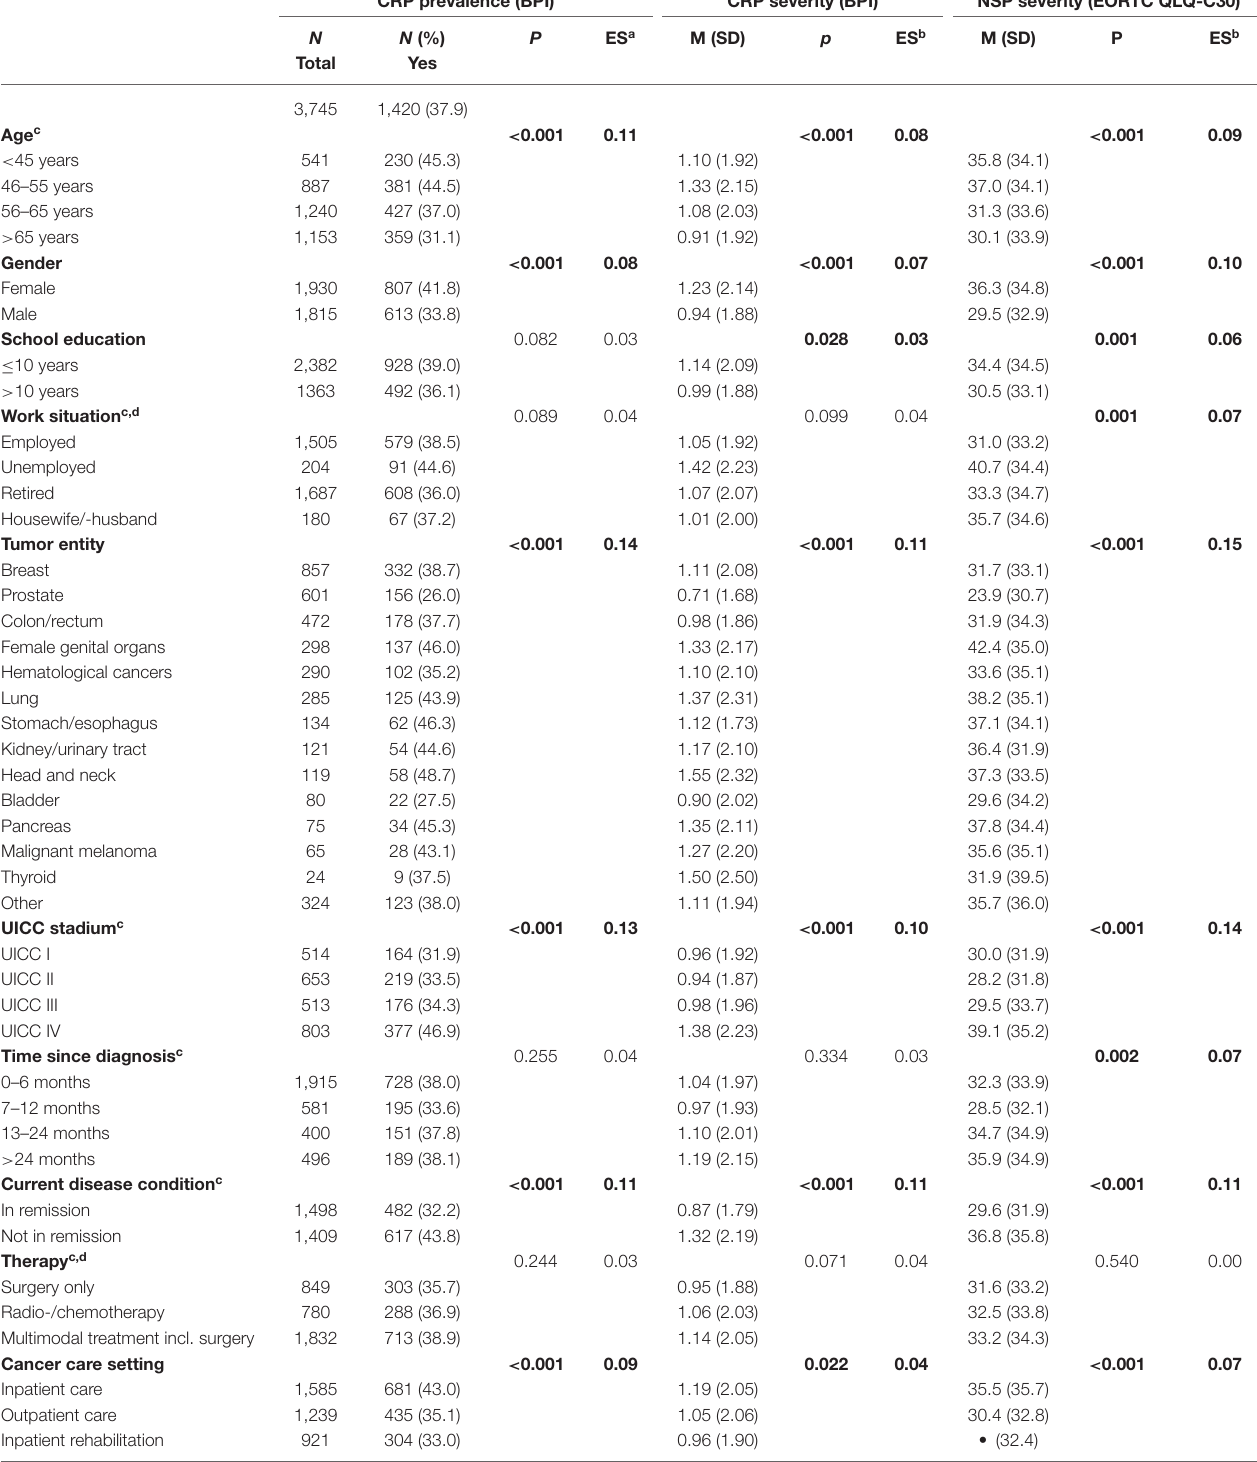
TABLE 1 | Sociodemographic and clinical characteristics with pain as dependent